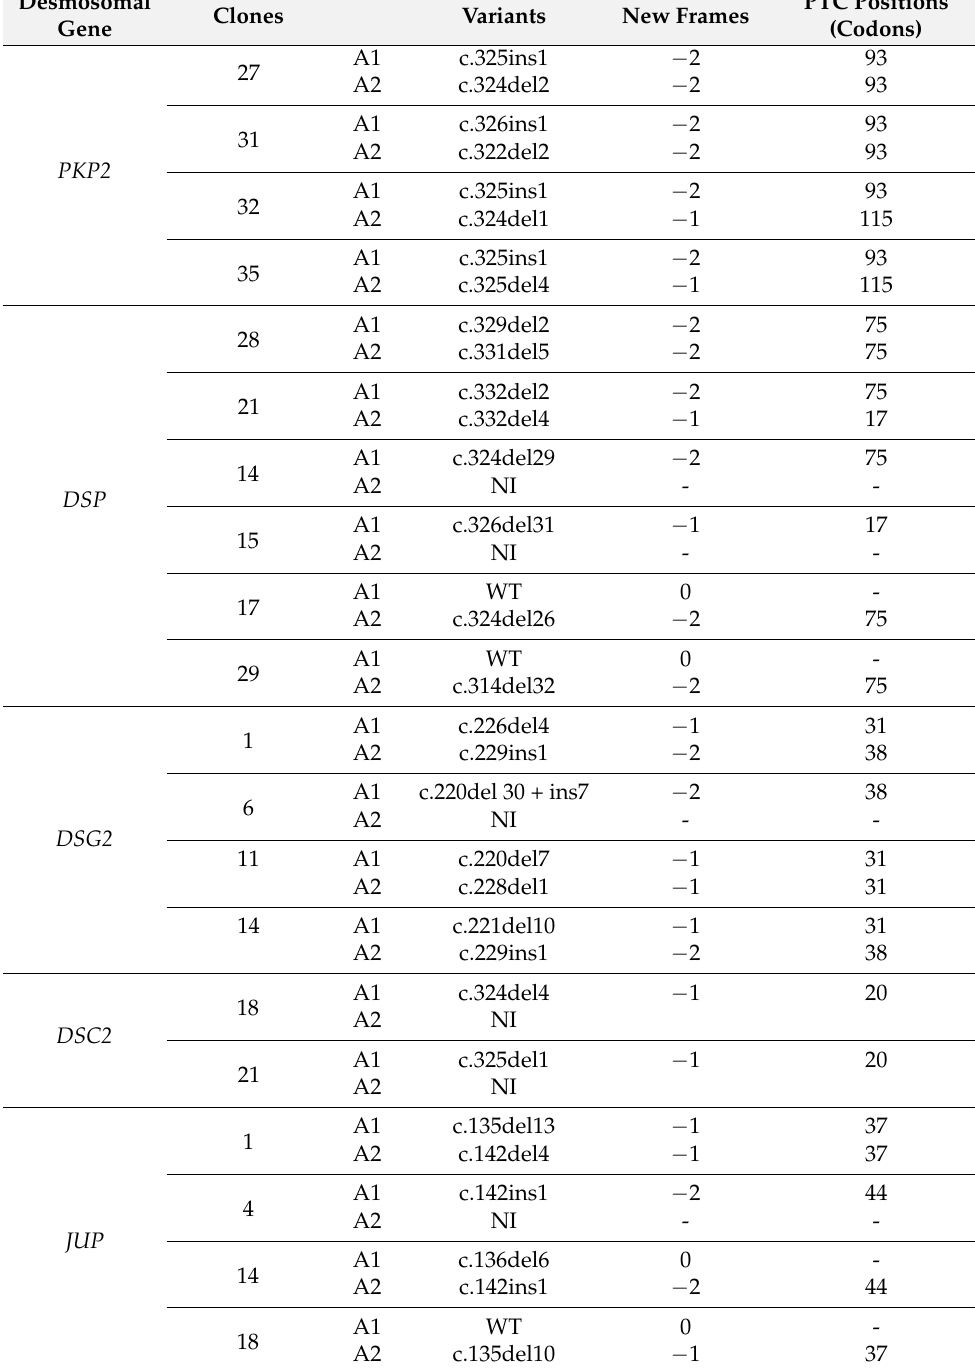
Table 1. CRISPR edited desmosomal gene